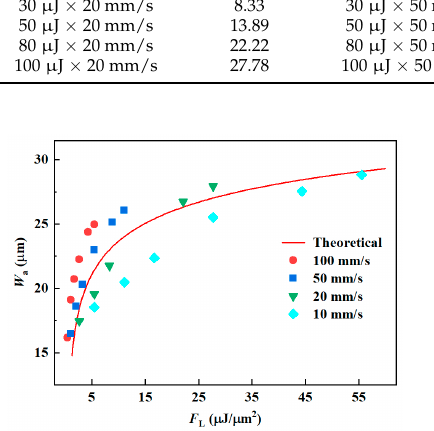
Figure 6. The W a of the microgroove changes with the F L .